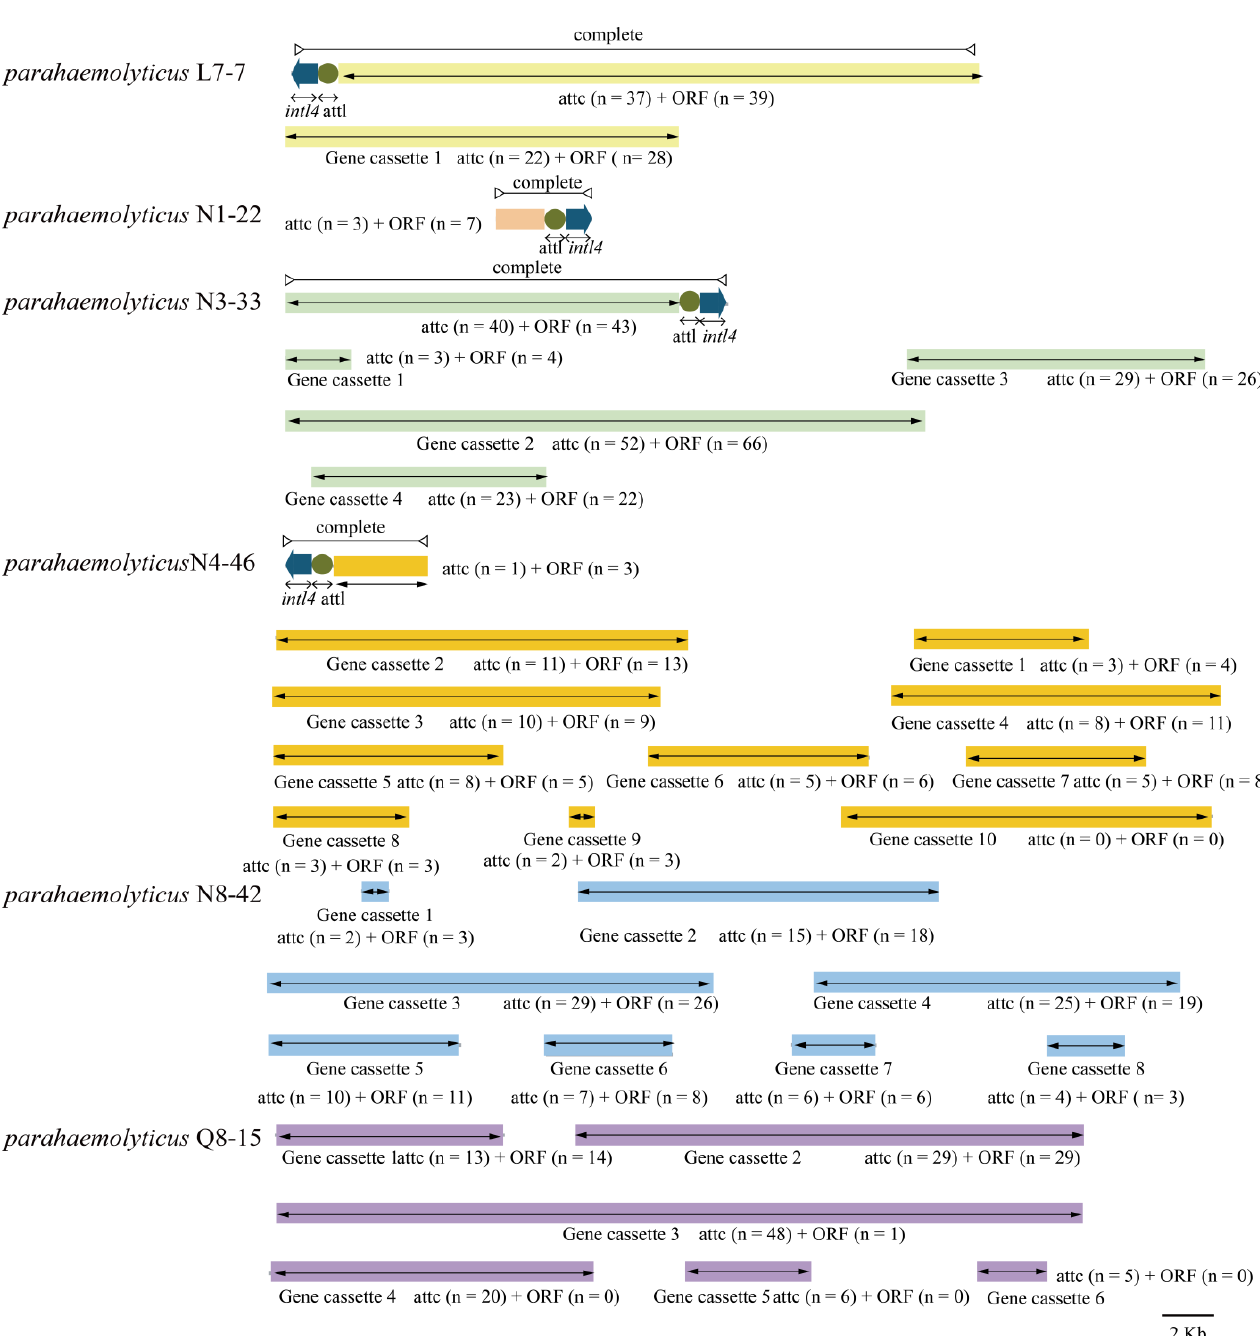
Figure 7. Structure diagram of the integrons identified in the six V. parahaemolyticus genomes. The complete integrons and incomplete gene cassettes identified in V. parahaemolyticus L7-7, N1-22, N3-33, N4-46, N8-42, and Q8-15 genomes are shown from light yellow to light purple, with the predicted attc / attl sites and ORFs.